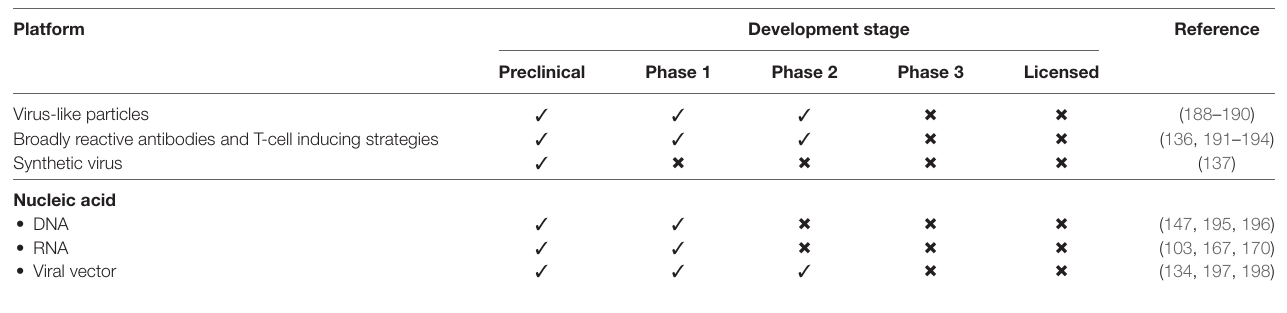
TABLe 1 | Current development stage of the influenza vaccines based on novel platforms.